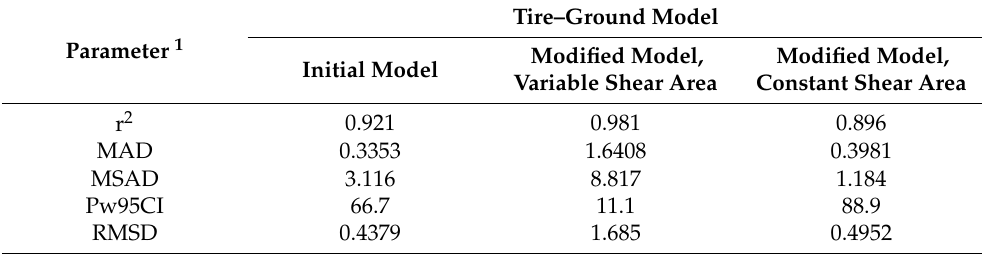
Table 4. Goodness-of-fit analysis: traction force of the 2 WD tractor with 65